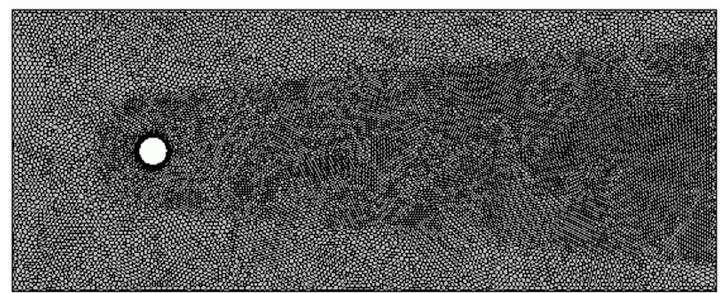
Figure 3. Mesh distribution around the cylinder.